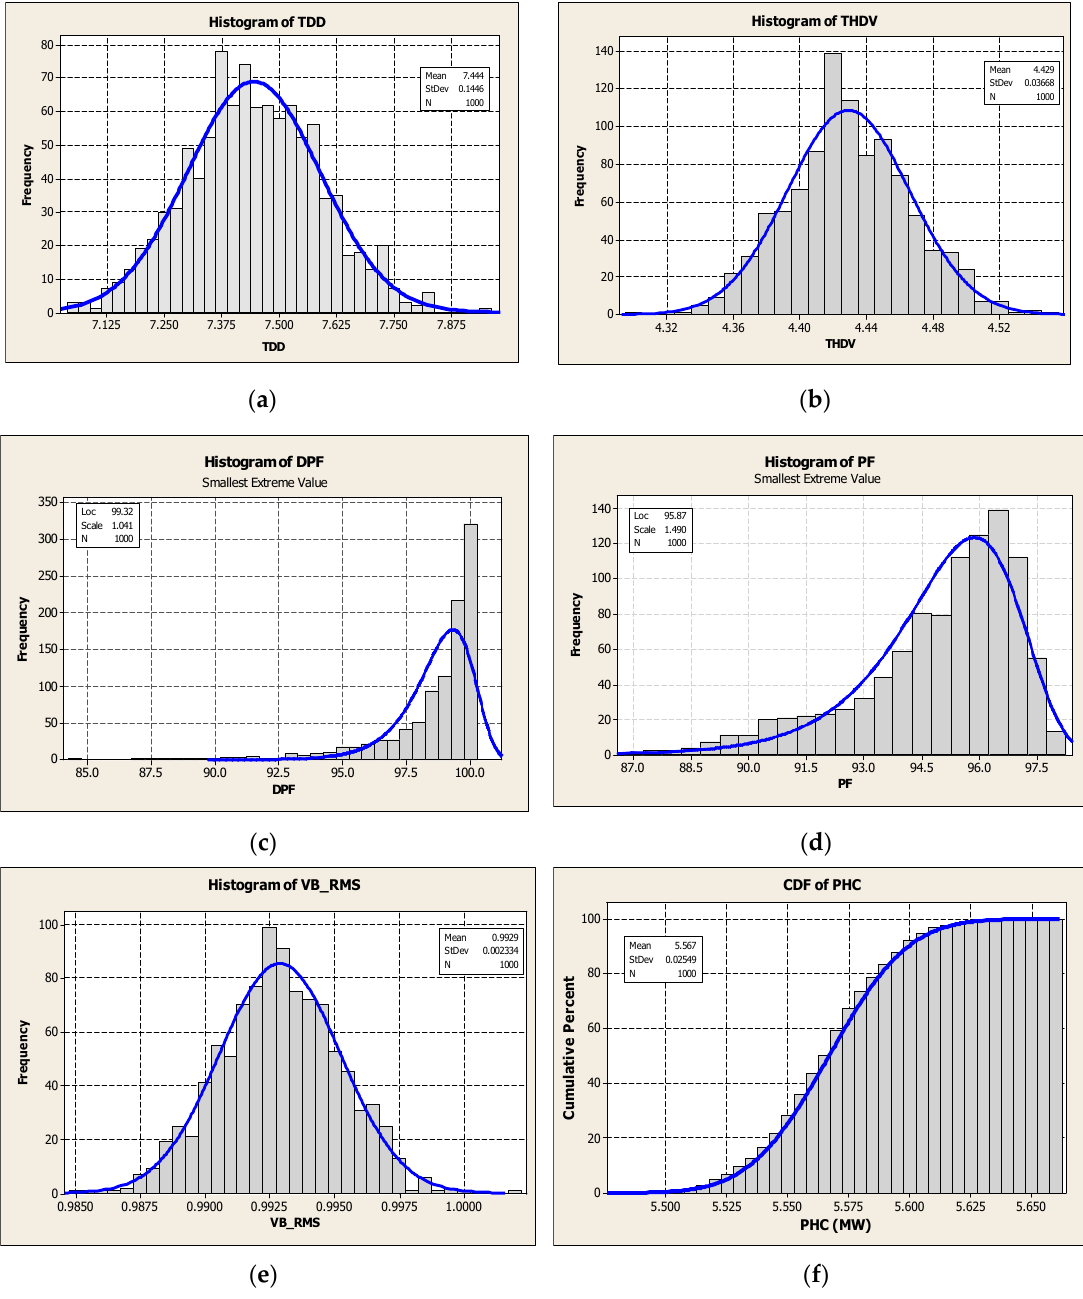
Figure 7. Results of the probabilistic performance indices and their corresponding PDFs: ( a ) total demand distortion (TDD), ( b ) total harmonic distortion for the voltage (THDV), ( c ) displacement power factor (DPF), ( d ) power factor (PF), and ( e ) bus voltage (rms); ( f ) cumulative distribution function of the PHC.